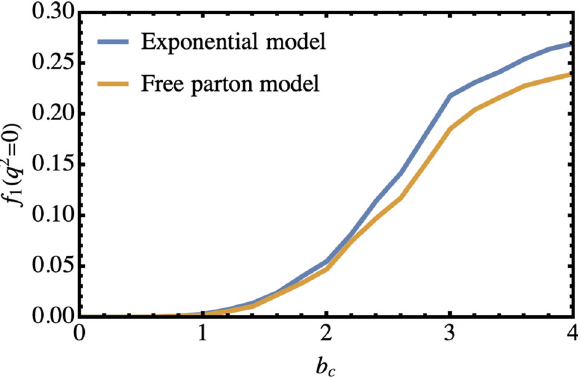
Fig. 4 Dependence of the form factor f 1 ( 0 ) on the cutoff b c